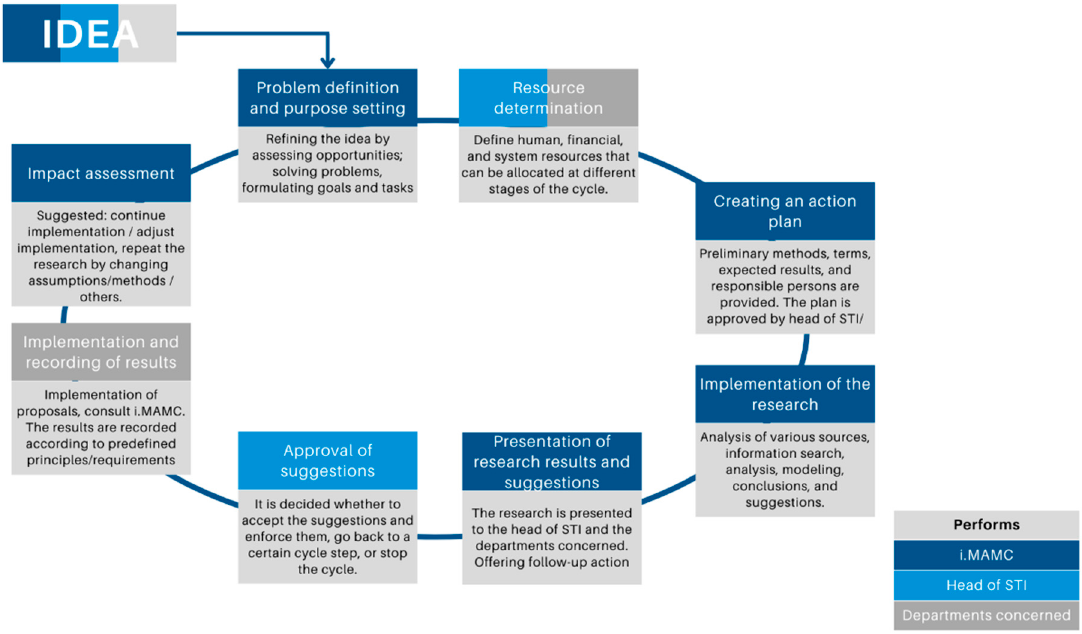
Figure 8. Diagram of cyclical implementation of tasks.